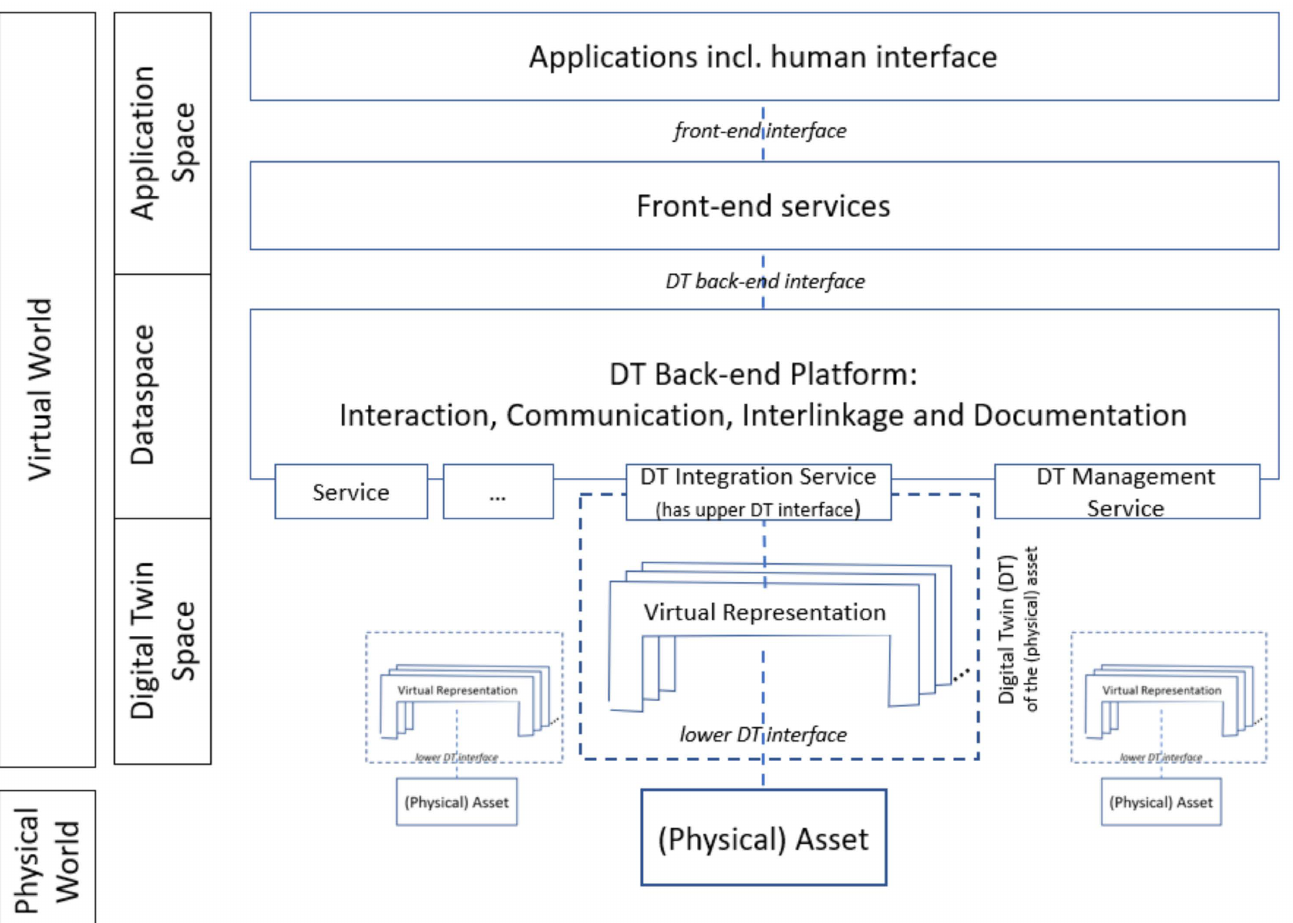
Figure 4. Digital Twin System Reference Model